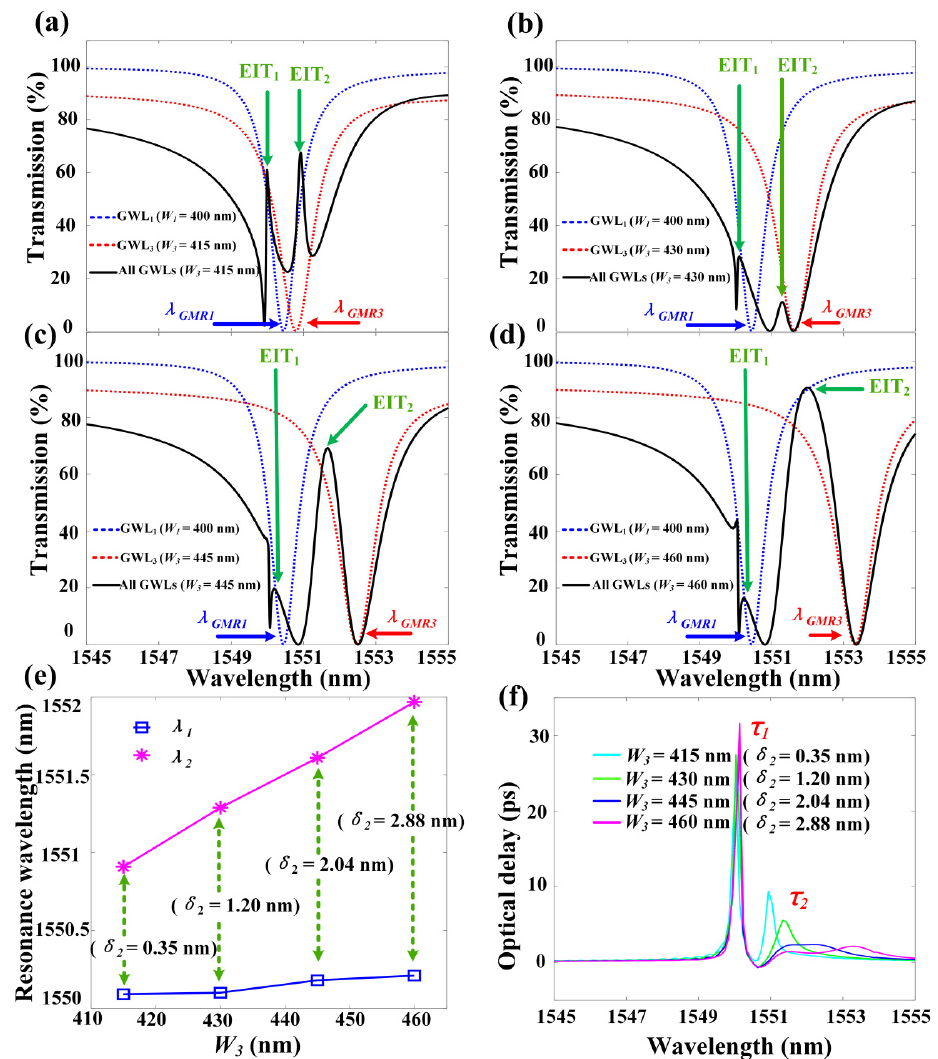
Figure 5. The transmission spectra and delay time under different W 3 (different δ 2 ); other parameters are the same as in Figure 1. ( a ) The transmission spectrum of the system when W 3 = 415 nm ( δ 2 = 0.35 nm); ( b ) The transmission spectrum of the system when W 3 = 430 nm ( δ 2 = 1.20 nm); ( c ) The transmission spectrum of the system when W 3 = 445 nm ( δ 2 = 2.04 nm); ( d ) The transmission spectrum of the system when W 3 = 460 nm ( δ 2 = 2.88 nm); ( e ) Two resonant wavelengths of two EITs under different W 3 (different δ 2 ); ( f ) Two delay times under different W 3 (different δ 2 ).